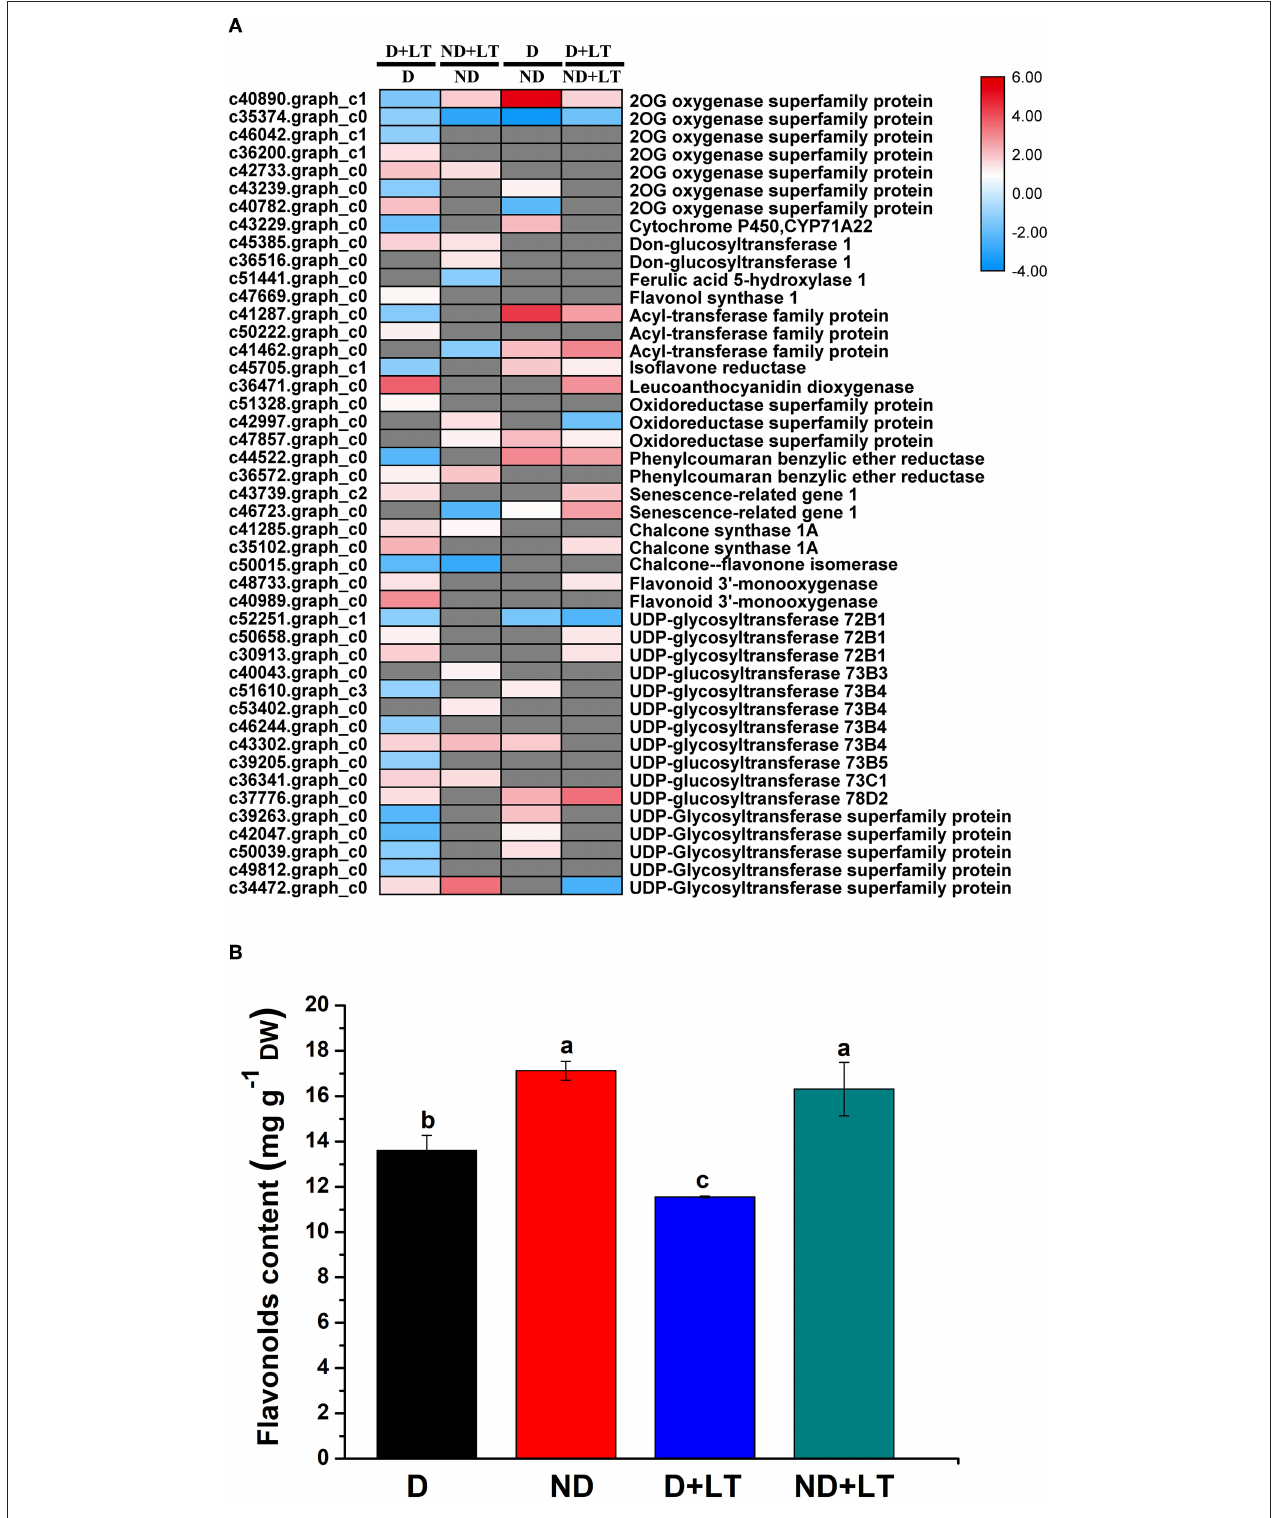
FIGURE 3 | Transcript profiles of flavonoids biosynthesis genes (A) and flavonoids content determination (B) in different dormancy varieties of alfalfa under LT. (A) The color scale indicates log 2 -transformed fold changes in expression levels between dormancy (D) and non-dormancy (ND) genotype under normal growth condition or LT condition. Red, blue, and gray denote upregulation, downregulation, and no change in expression, respectively. (B) Flavonoids contents of dormancy (D) and non-dormancy (ND) alfalfa varieties under LT condition. Columns marked with different letters indicate significant differences among treatments based on the LSD value ( p ≤ 0.05; n =